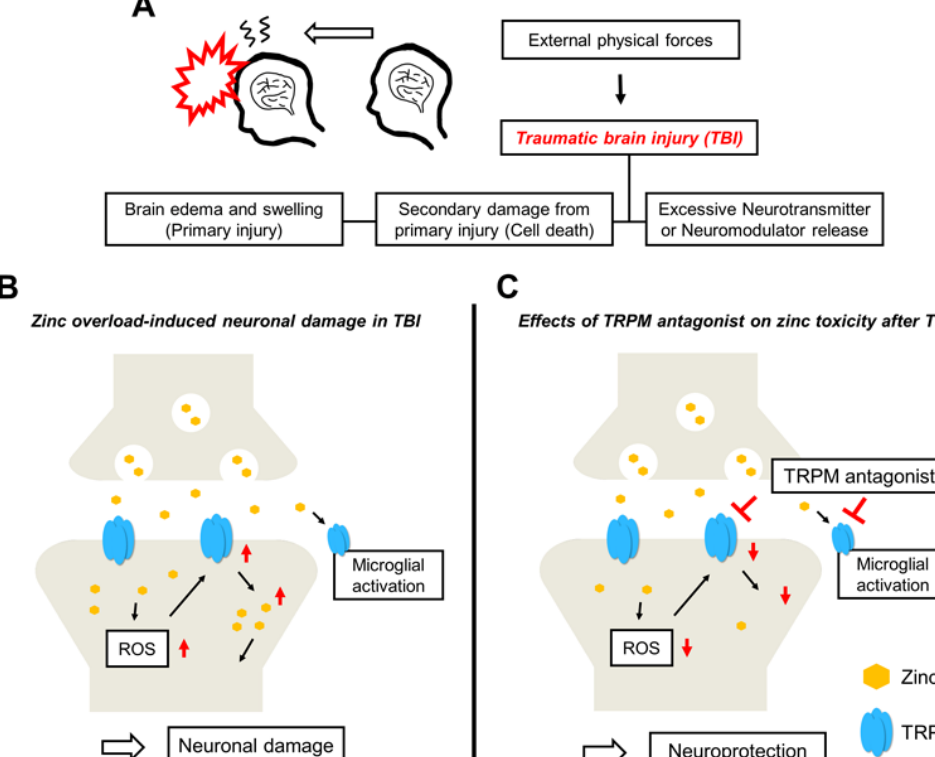
Figure 3. Proposed cascades for the neuroprotective effects of TRPM antagonists on traumatic brain- injury-induced neuronal death: ( A ) The main causes of TBI are external physical forces and stimuli. TBI-induced primary damage produces brain edema, and swelling is caused instantly. Secondary damage from primary insult leads to deleterious cellular cascades. ( B ) Schematic drawing showing how the possible cascades via TBI induce neuronal damage. Excessively released zinc from pre- synaptic vesicles and zinc accumulated through the TRPM channel can trigger ROS production and, thereby, trigger further activation of TRPM, leading to an increase in the intracellular zinc concen- tration. This concentration of zinc contributes to neuronal damage. ( C ) Possible neuroprotective properties of TRPM antagonists. Reduced post-synaptic zinc entering through the TRPM channel via antagonists can reduce neuronal